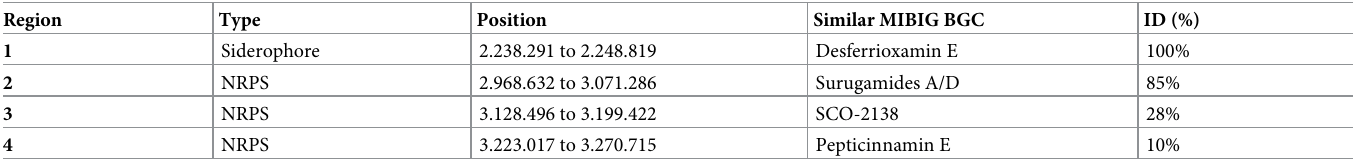
Table 1. BGCs of secondary metabolites predicted for Streptomyces sp. BRB081. Region